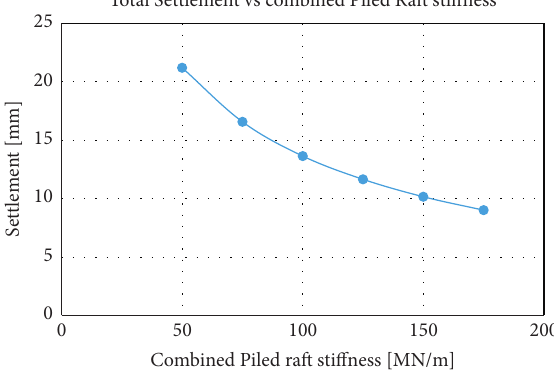
Figure 13: Variation of total settlement with stiffness.